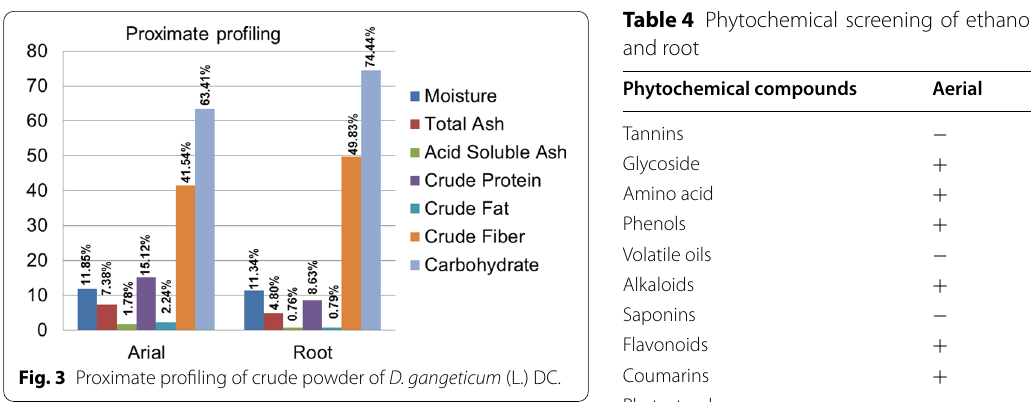
Fig. 2 Powder microscopy of D. Gangeticum. A Epidermis ( crystals of calcium oxalate (